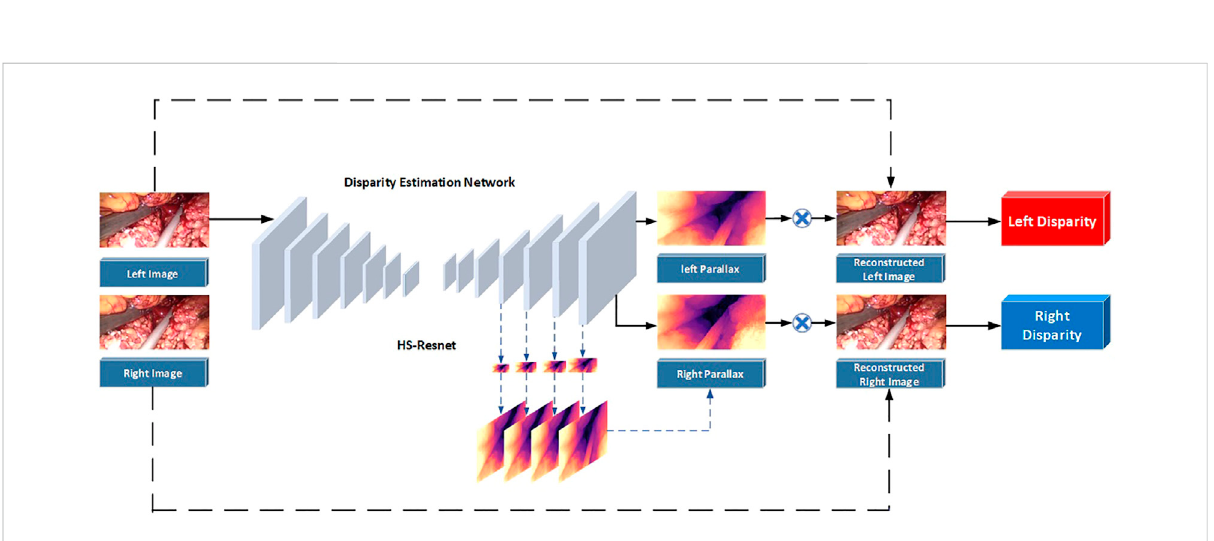
FIGURE 5 Flowchart of the parallax estimation